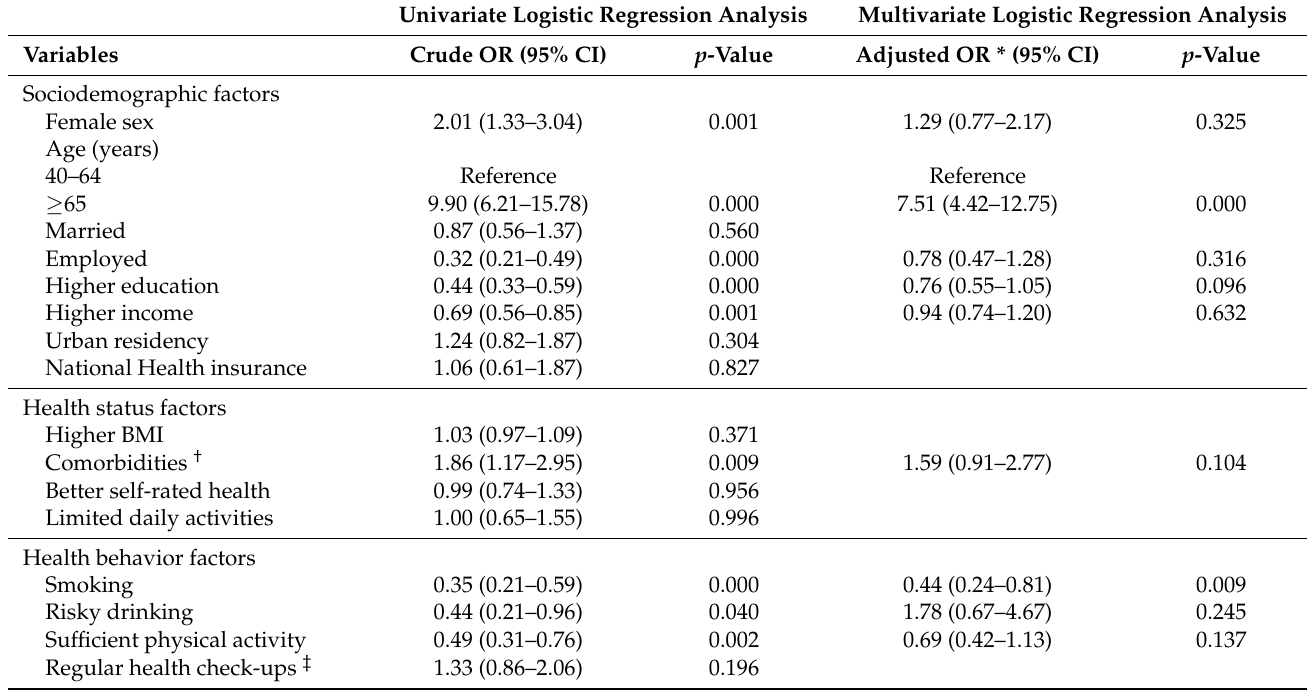
Table 3. Factors associated with influenza vaccination status among stroke survivors (n = 591).